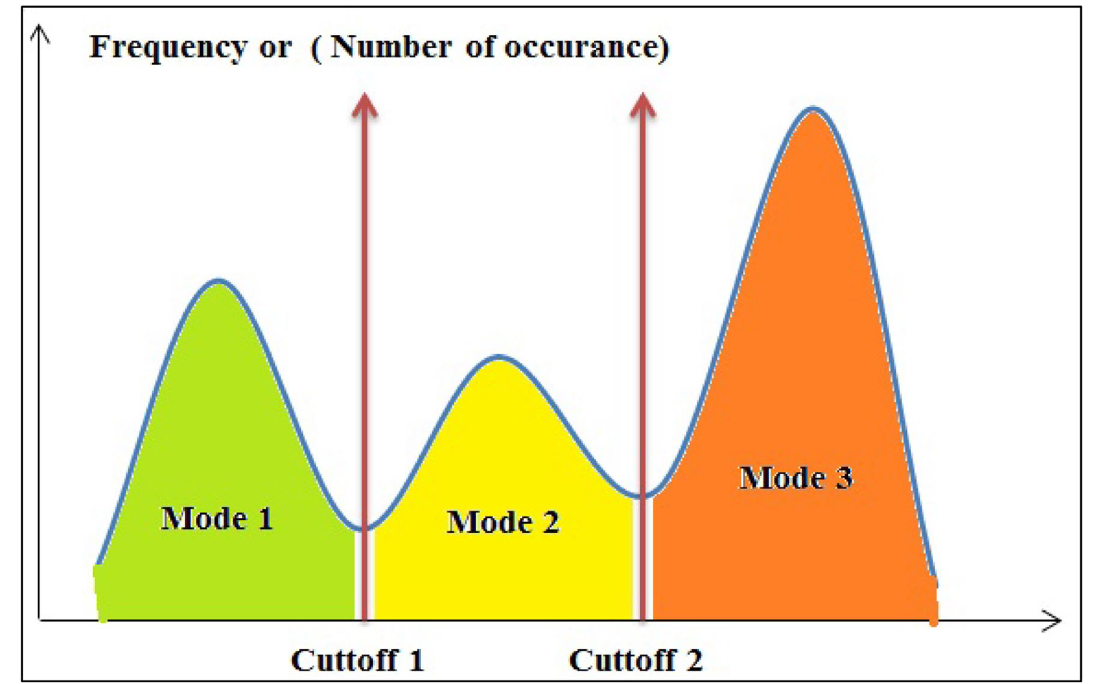
Fig. 4 Histogram of the image log